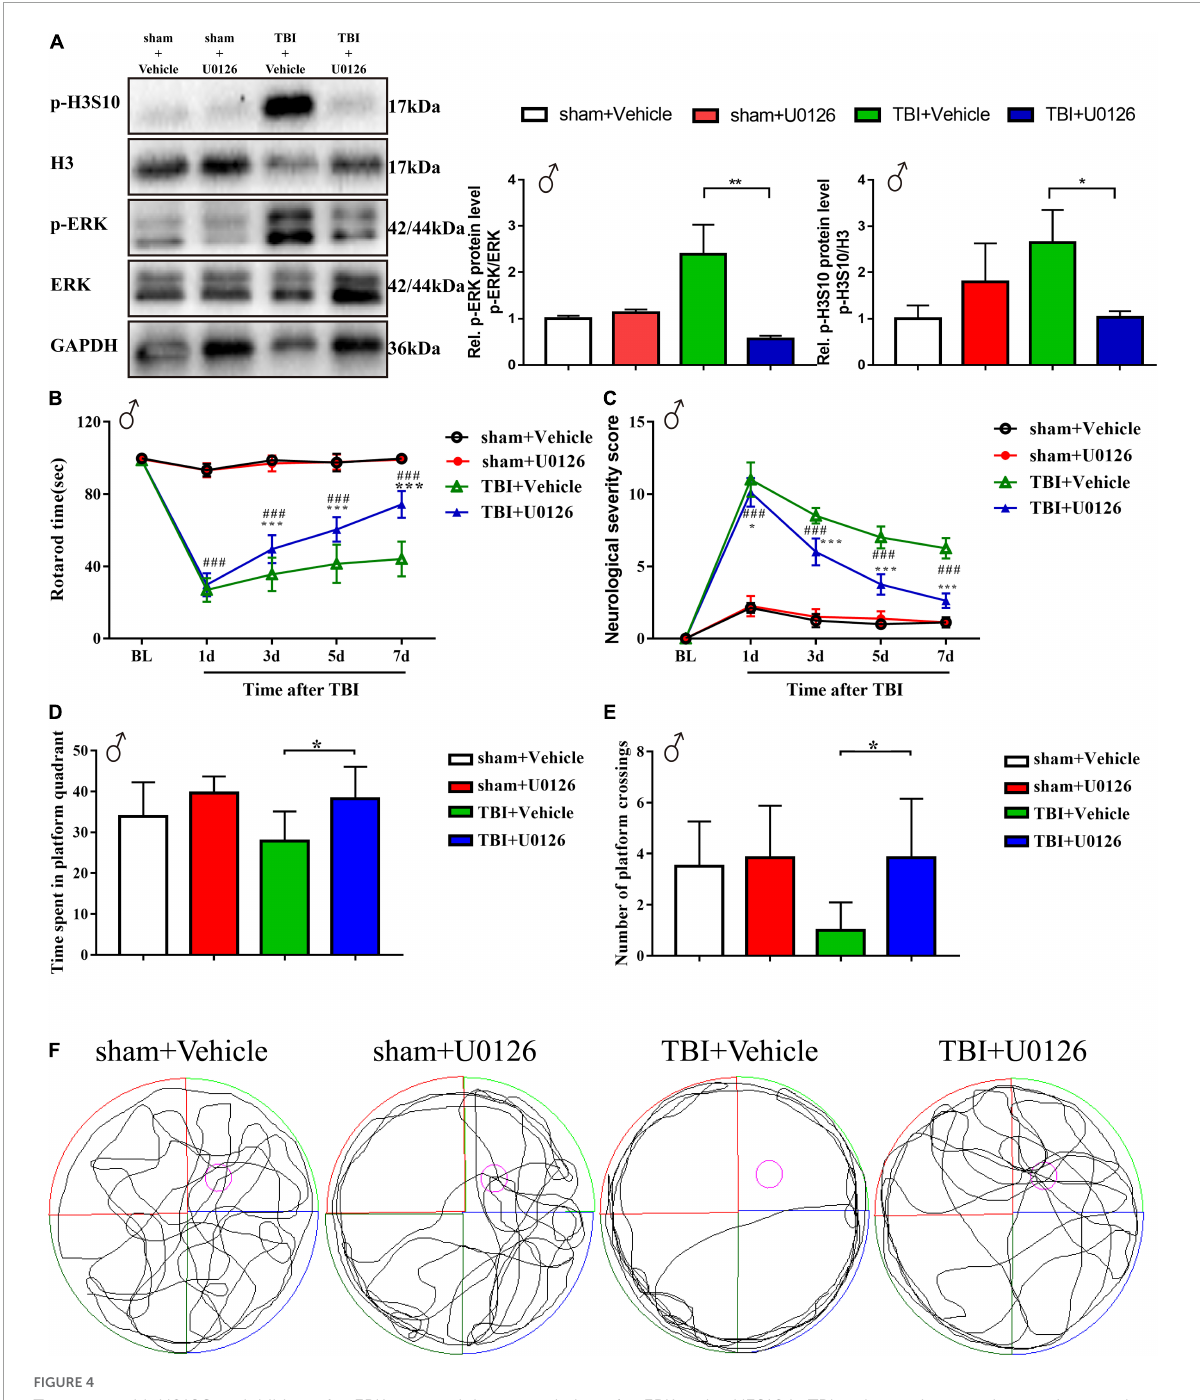
FIGURE4 Treatment with U0126, an inhibitor of p-ERK, reversed the upregulation of p-ERK and p-H3S10 in TBI male rats, improved rotarod test and Morris water maze test performance, and attenuated neurological severity score in TBI male rats. Western blot analysis showed that the phosphorylation levels of (A) ERK (** p < 0.01) and H3S10 (* p < 0.05) were reversed by U0126 treatment in the TBI rats ( n = 6 rats/group. Mann–Whitney test. TBI + U0126 vs. TBI + vehicle. The values are expressed as the means ± SD). Motor function was improved between the third and seventh days after injury by U0126 as shown in the rotarod test (B) and neurological severity score test (C) ( n = 8 rats/group. Two-way ANOVA with repeated measures followed by Tukey’s multiple comparisons test. * p < 0.05, *** p < 0.001, TBI + U0126 vs. TBI + vehicle; ### p < 0.001, TBI + U0126 vs. sham + U0126. The values are expressed as the means ± SD). Cognitive function was improved as shown in the Morris water maze test (D,E) ( n = 6 rats/group. One-way ANOVA followed by Dunnett’s multiple comparisons test. * p < 0.05, TBI + U0126 vs. TBI + vehicle. The values are expressed as the means ± SD). (F) The swim paths shown for sham + U0126, sham + vehicle, TBI + vehicle and TBI + U0126 groups were those of a single male animal in the probe test. The hidden platform was indicated by the purple